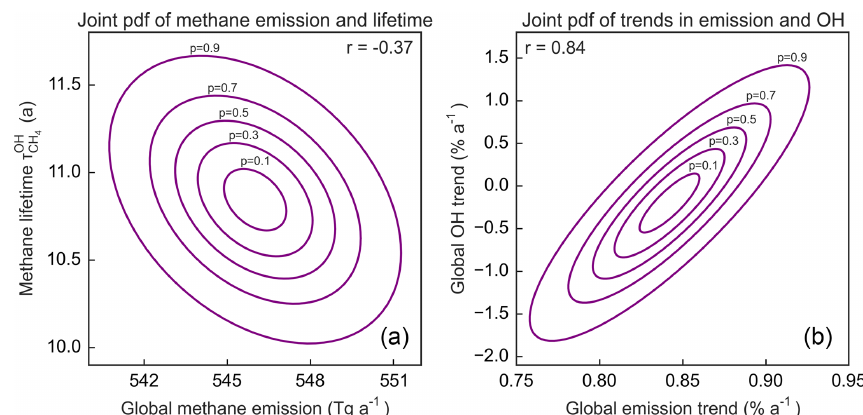
Figure 9. Joint probability density functions (pdfs) for the global methane budget as constrained by the 2010–2015 GOSAT data. Panel (a) shows the joint pdfs of the 2010–2015 global mean methane emission and methane lifetime against oxidation by tropospheric OH. Panel (b) shows the joint pdfs of the 2010–2015 global emission trend and the OH trend. Contours show confidence ranges from 0.1 to 0.9. The error correlation coefficients are shown inset. The tilt of the ellipse indicates the extent of error